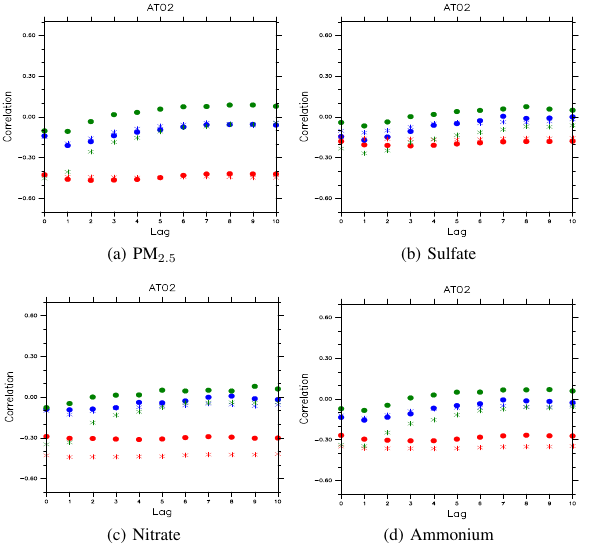
Fig. 4. Correlations between meteorology (temperature in red, pre- Fig. 4 : Correlations between meteorology (temperature in red, precipitation in blue, wind speed cipitation in blue, wind speed in green) on a given day and pollutant in green) on a given day and pollutant concentrations (PM 2 . 5 , sulfate, nitrate and ammonium), concentrations (PM 2 . 5 , sulfate, nitrate, and ammonium), ranging up ranging up to 10 days after at AT02 (2003-2008). Simulated data are represented with a star, to 10 days after at AT02 (2003–2008). Simulated data are repre- while observational data are represented with a dot. sented with a star, while observational data are represented with a dot.